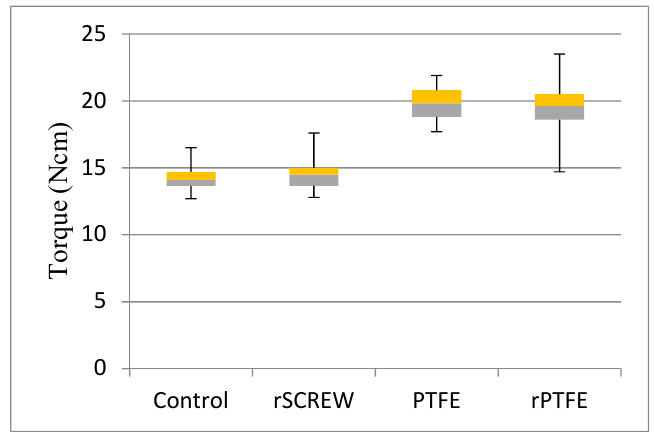
Figure 6. Boxplot of RTVs for control ( n = 15) and experimental groups ( n = 15).